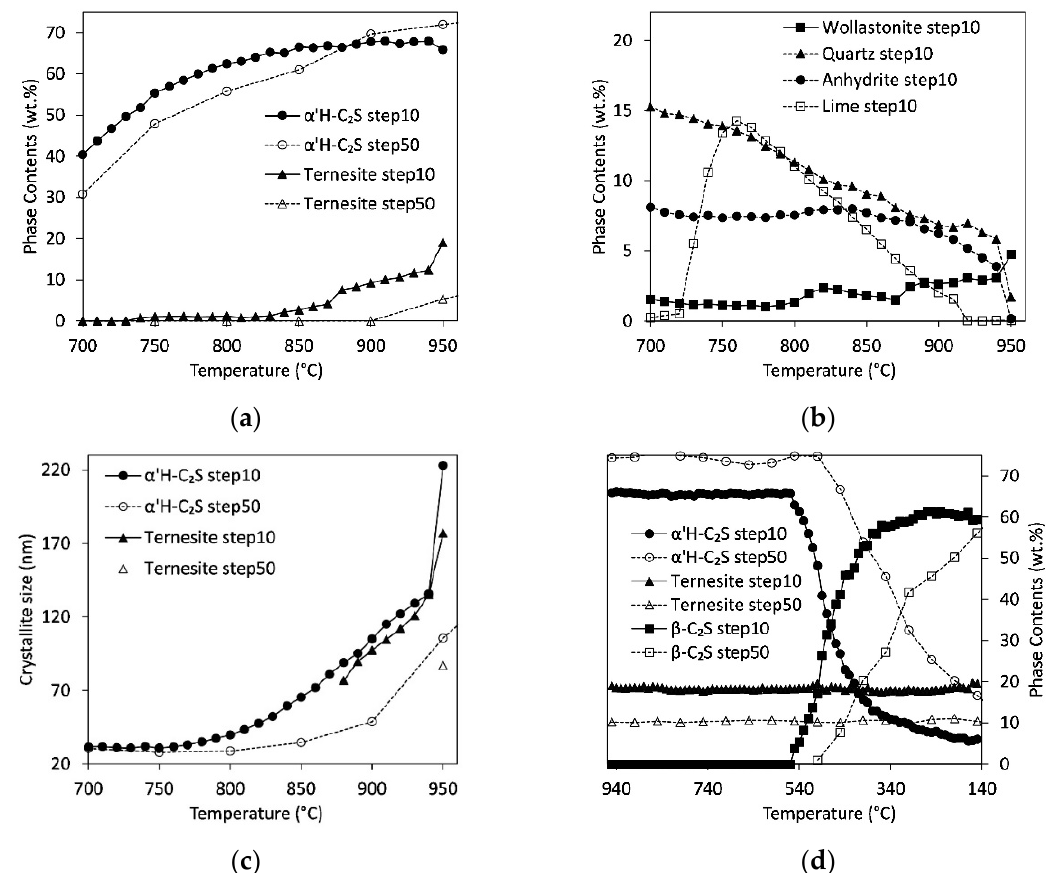
Figure 5. Long-time experiment with heating and cooling steps of 10 °C/20 min compared to standard experiment with 50 °C/12 min (D3). ( a ) Comparison of the formation of α ’H-C 2 S and ternesite with slow (step10) and high (step50) heating rate. ( b ) Variation of wollastonite, quartz, anhydrite, and lime phase contents with low heating rate. ( c ) Comparison of crystallite sizes for ternesite (for phase contents >5 wt.%) and α ’H-C 2 S. ( d ) Effect of the decrease in heating rate on β -C 2 S formation during cooling.